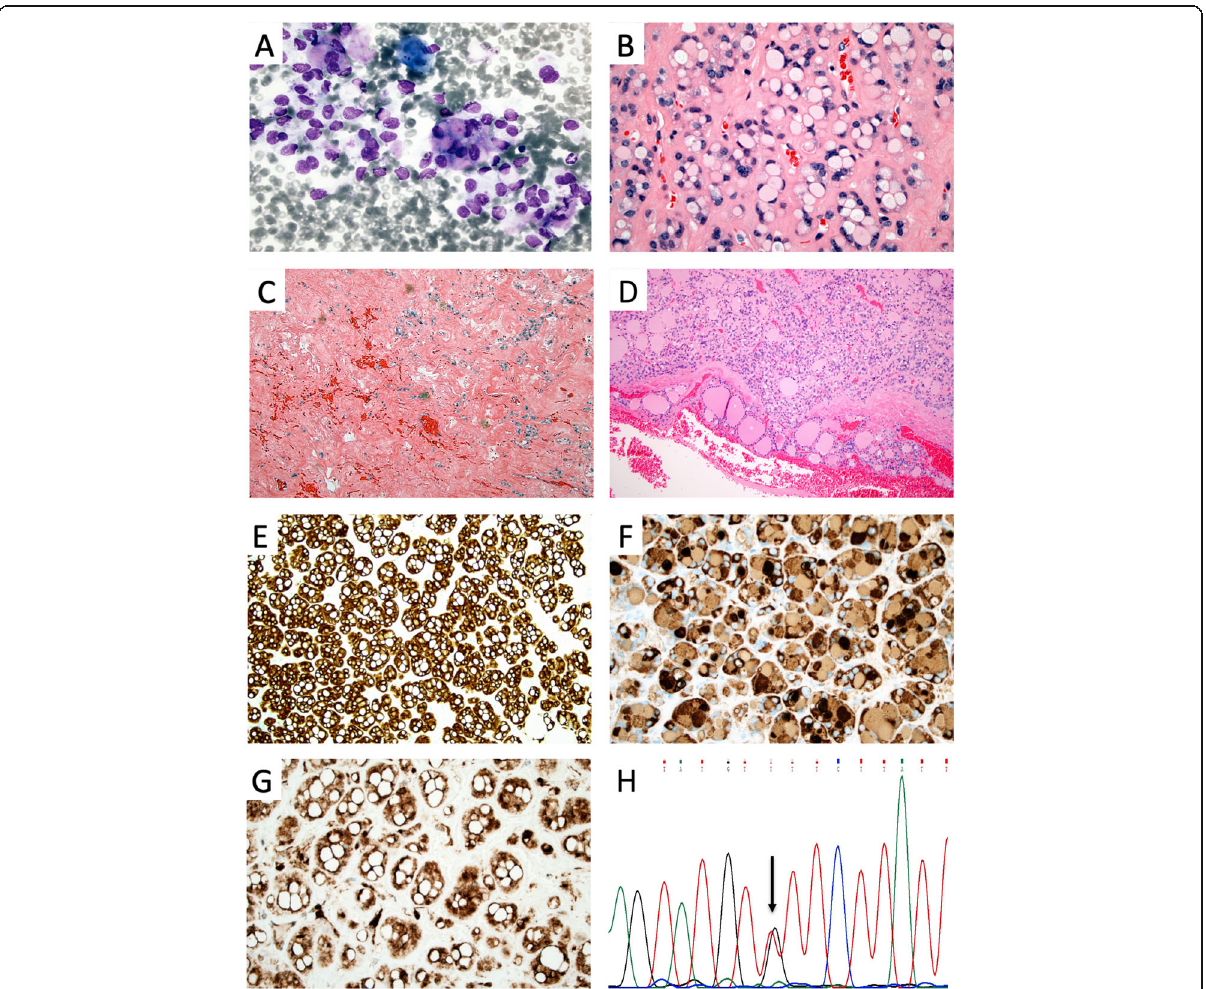
Fig. 2 Cytological and histological illustrations of case 2. a Cytological preparation from the thyroid lesion at × 600 magnification depicting thyrocytes with large, irregular nuclei with suggestive nuclear marginalization in subsets of cells. The vast majority of cells were without this phenomenon, and no evident signet-ring cell phenotype was observed. b H&E staining of the thyroid tumor at × 400 magnification, showing thyrocytes with signet ring cell morphology in subsets (30 – 50%) of tumor cells. c Central parts of the lesion displayed a dense fibrous meshwork with focal hemorrhages and only sparsely found tumor cells. d One of several areas with capsular invasion, × 100 magnification. e-g Immunohistochemical analyses at × 400 magnification; Cytokeratin MNF116 cytoplasmic stain ( e ), thyroglobulin cytoplasmic stain, including subsets of vacuoles ( f ) and PTEN nuclear and cytoplasmic staining ( g ). h: Chromatogram displaying the c.209 + 11 T > G PTEN mutation in leukocyte DNA. The red line represents the wildtype thymine (T) and the black line represent the mutant guanine ( g ) at position c. 209 +